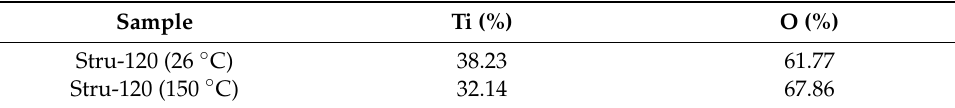
Table 1. Atomic number percentage of Ti and O in different